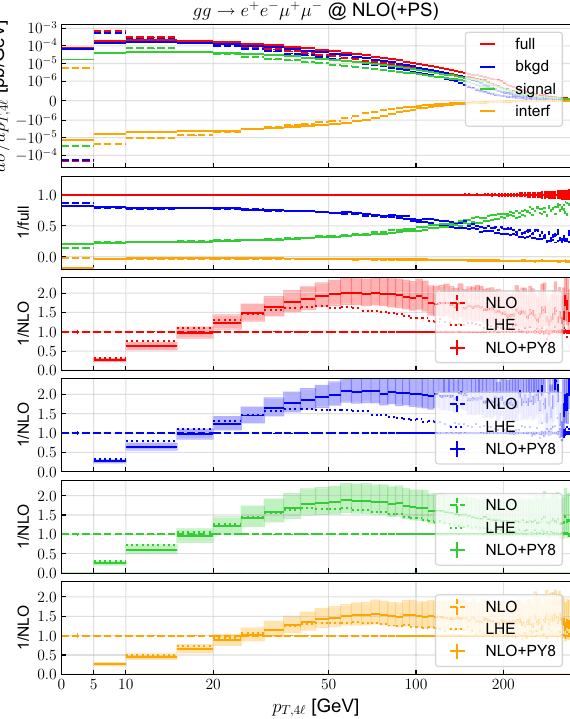
Fig. 5 Differentialdistributioninthetransversemomentumofthefour lepton system p T , 4 (cid:3) in gg → e + e − μ + μ − matched to PYTHIA 8 . Predictions, colour coding and bands as in Fig.